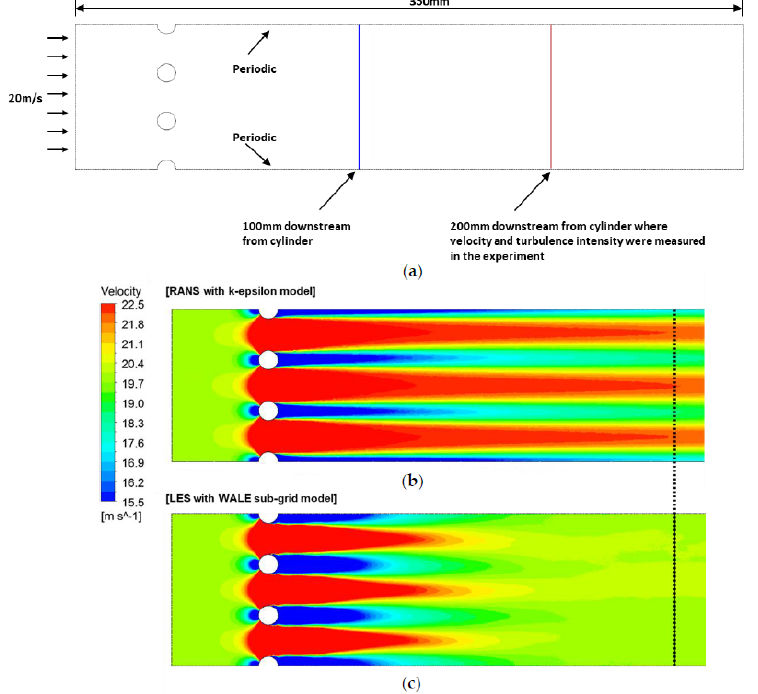
Figure 4. ( a ) Two dimensional CFD domain for validating circular cylinder downstream flow field; Comparison of velocity distributions between ( b ) steady state RANS with k − epsilon model and ( c ) LES with WALE sub − grid model.